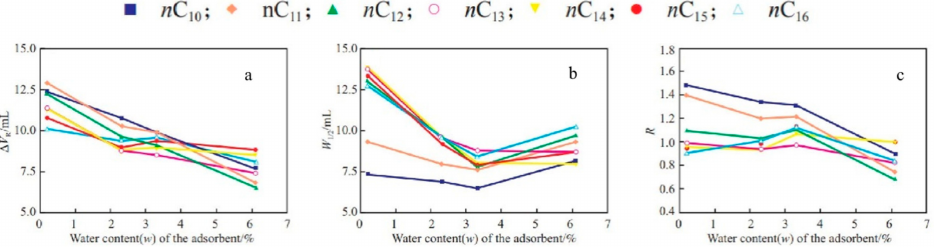
Figure 7. Relationship between pulse parameters of nC 10–16 and water content of adsorbent [36] the values of ( a ) ∆ V R ( b ) W 1/2 ( c ) R